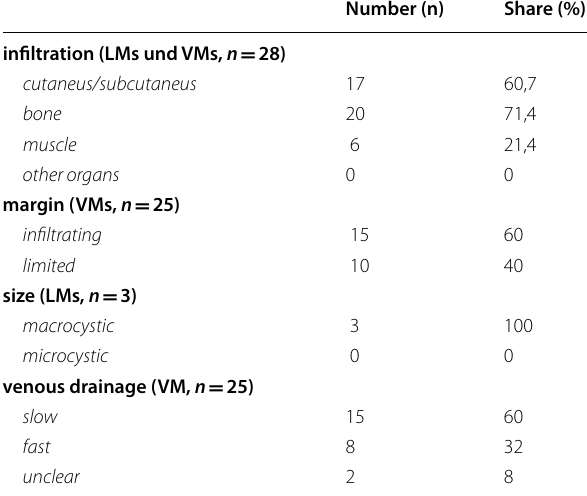
Table 6 Imaging features of sfMs